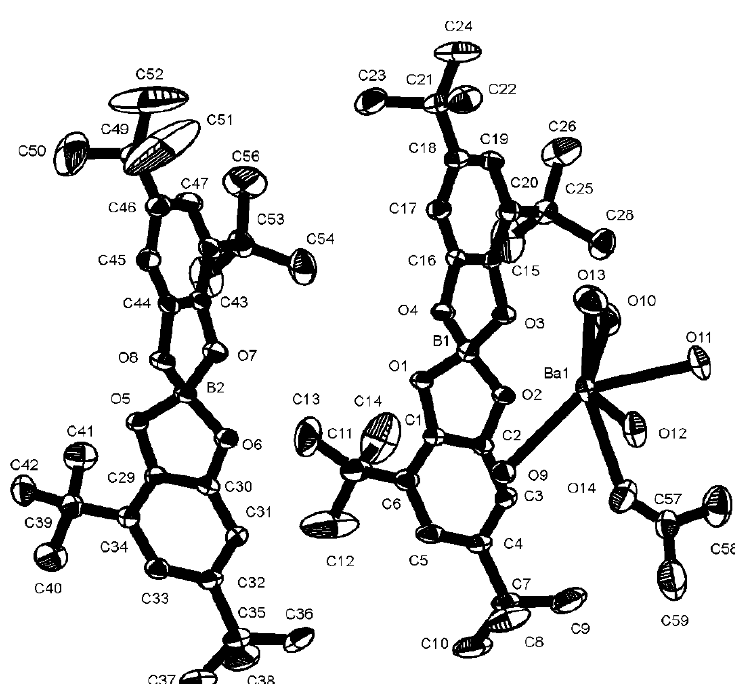
Figure 2. Molecular structure of the barium dimer {( h 1 -C